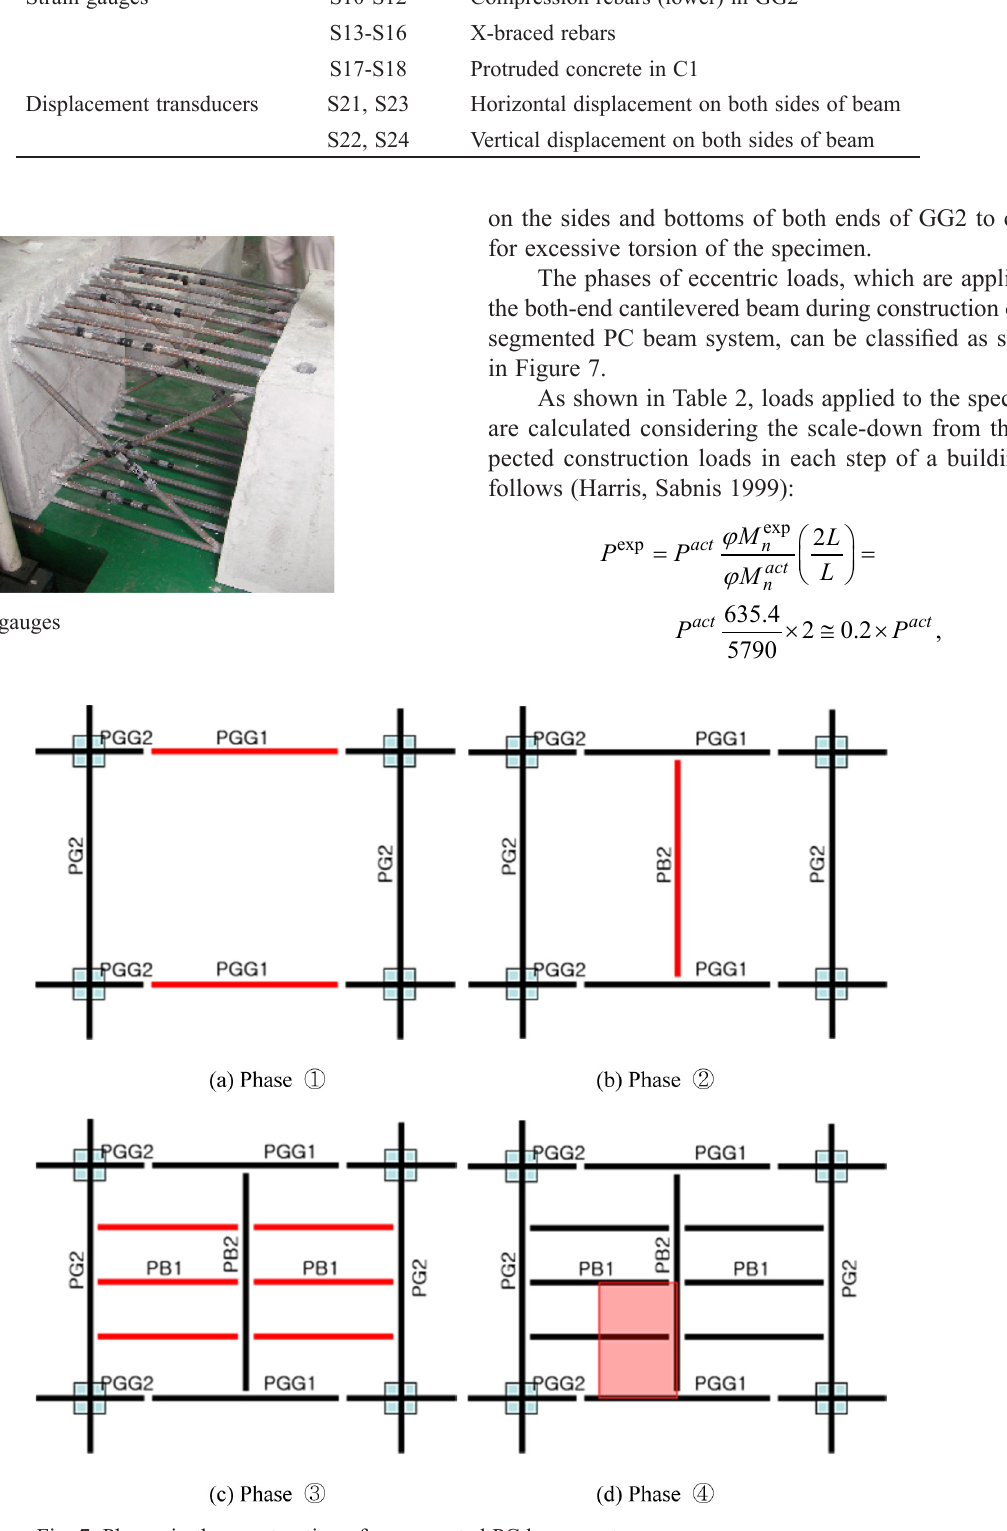
Fig. 7. Phases in the construction of a segmented PC beam